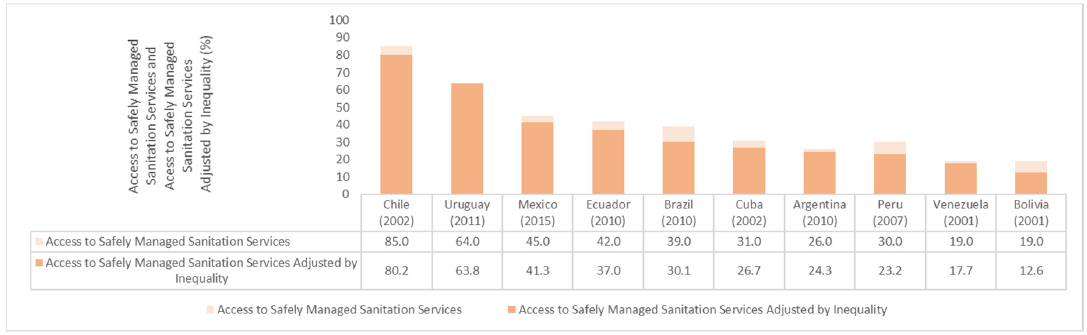
Figure 5. Access to safely managed sanitation services and access to safely managed sanitation services adjusted for inequality. Source: Own elaboration based on census microdata from the IPUMS-International Project [25].